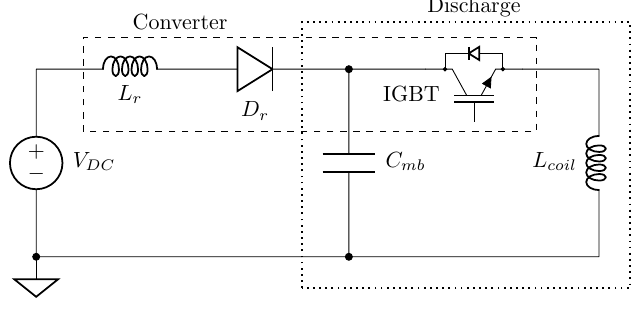
Figure 20. Simplified circuit diagram of the pulse charging PPU used to recharge the capacitor bank of the ELF thruster during continuous operation (based on schematic from